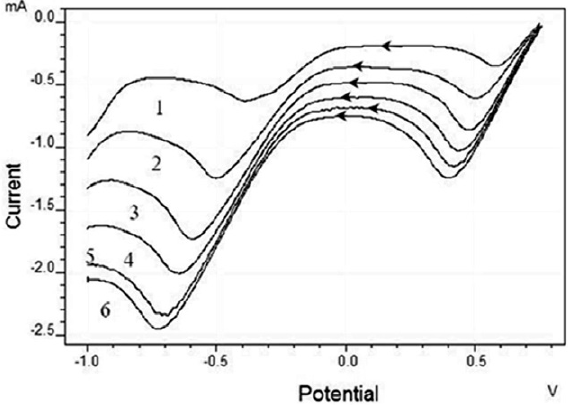
Fig. 5. The effect of the scan rate on the electroreduction of iron (III) ions. Electrolyte composition in (M): 0,1 Fe(NO 3 ) 3 · 9H 2 O + CH 2 OH-CH 2 OH. Scan rate (V/s): 1-0,005; 2- 0,02; 3- 0,04; 4- 0,06; 5- 0,08; 6- 0,1. At Т = 293 К.